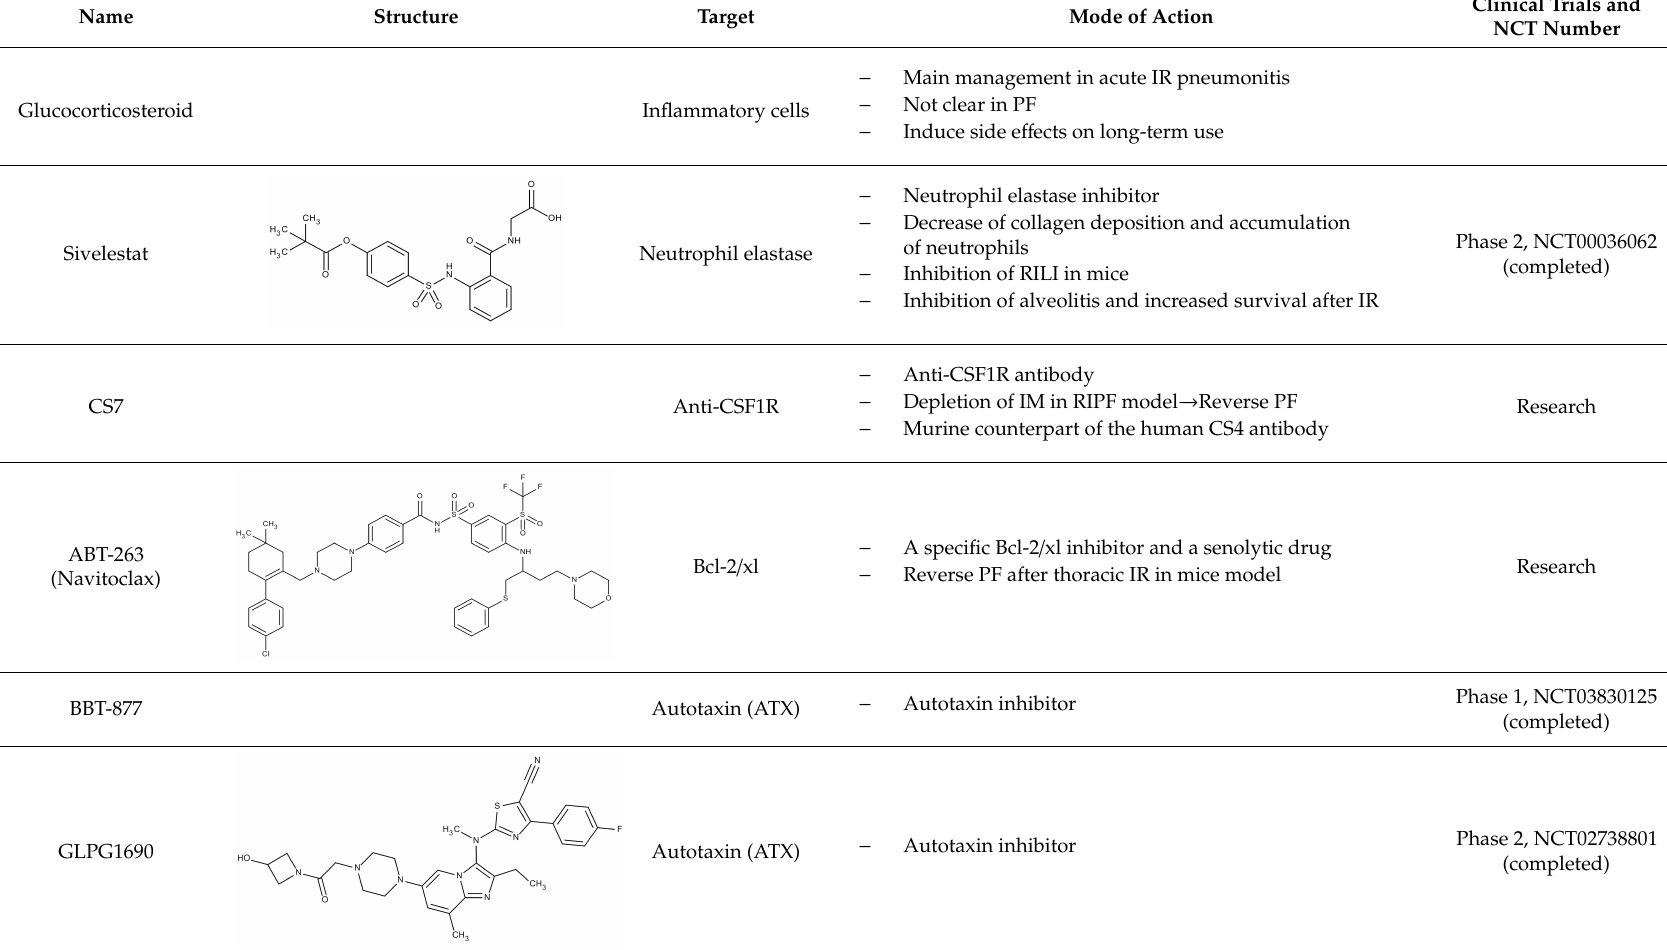
Table 3. Therapeutic targets for radiation-induced pulmonary fibrosis